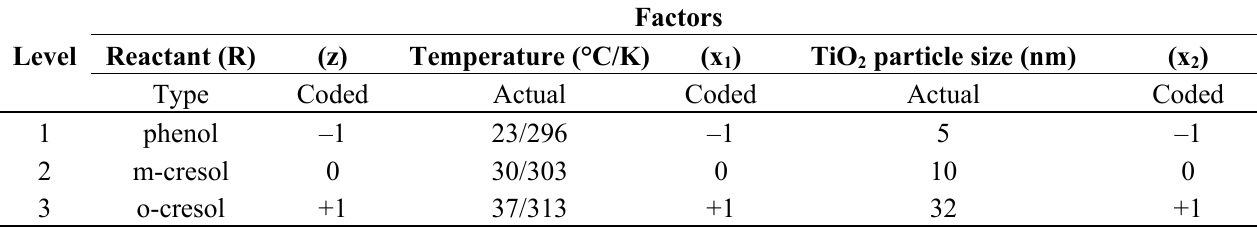
Table 2. Experimental design parameters.